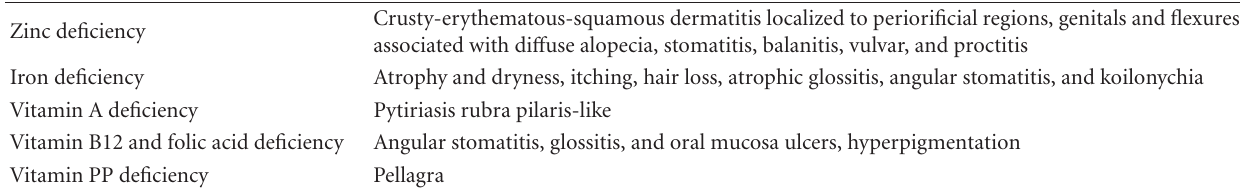
Table 2: Dermatological manifestation secondary to nutritional